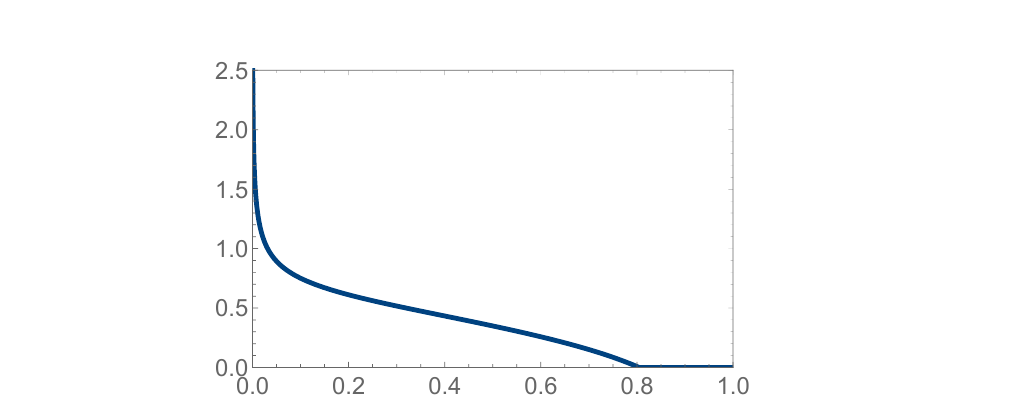
Figure 7. Plots of E 1 versus x .